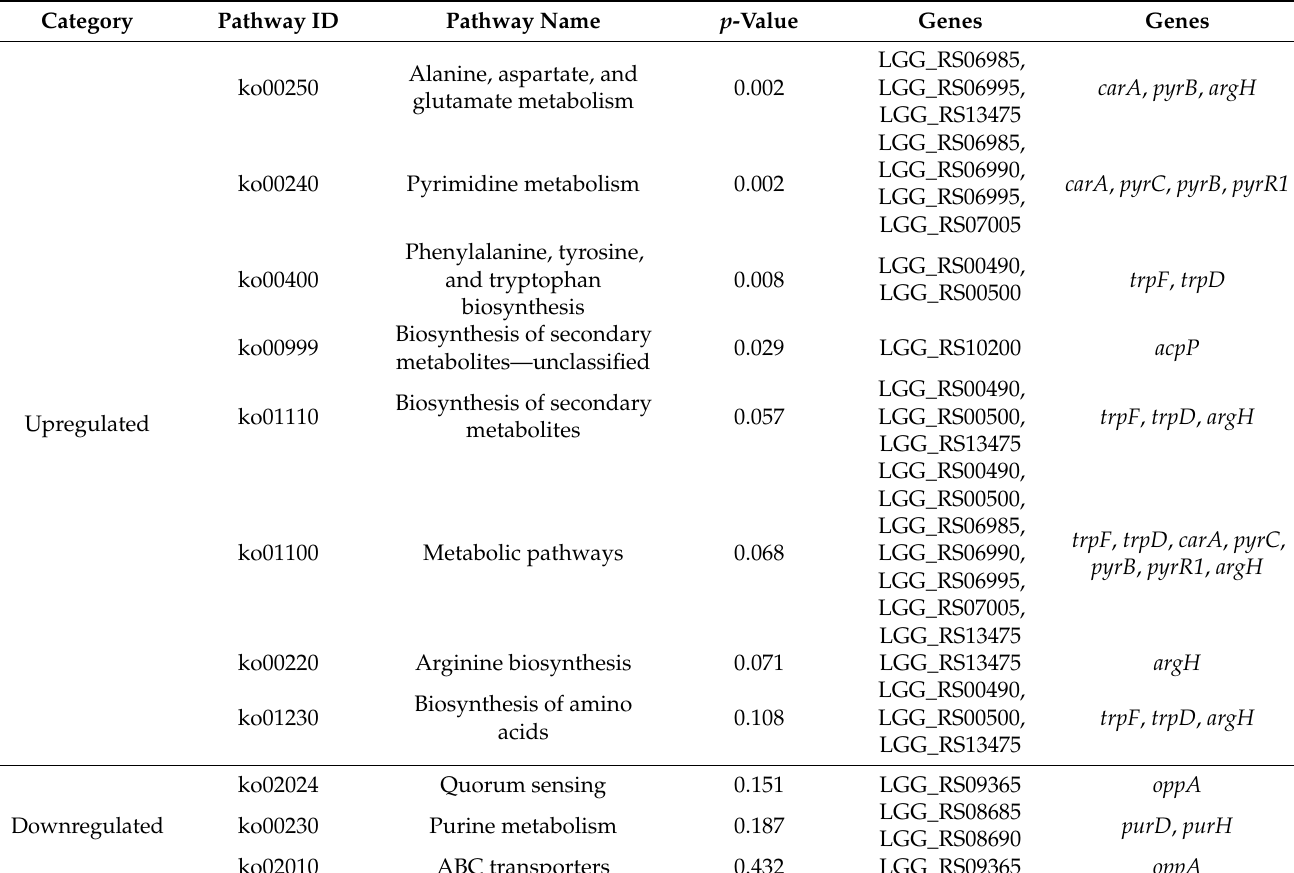
Table 2. DEG enrichment results of TE with KEGG pathway